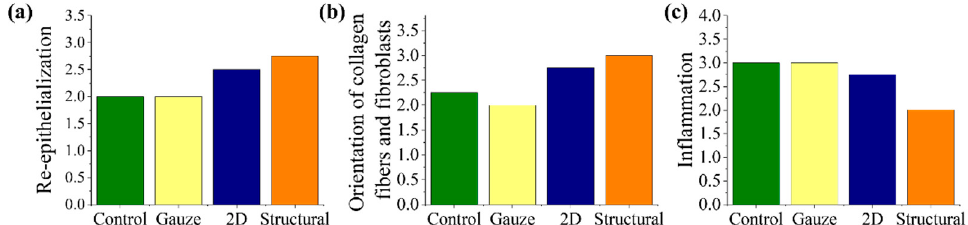
Figure 11. Histological scoring of ( a ) re-epithelization, ( b ) orientation of collagen fibers and fibroblast cells and ( c ) inflammation.